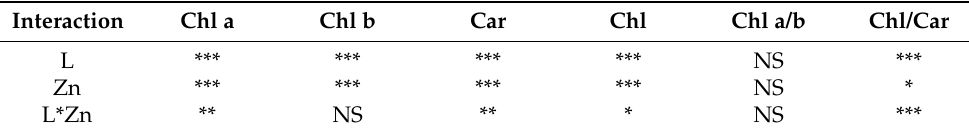
Table 3. The interaction effects on pigment content in flowering Chinese cabbage sprouts